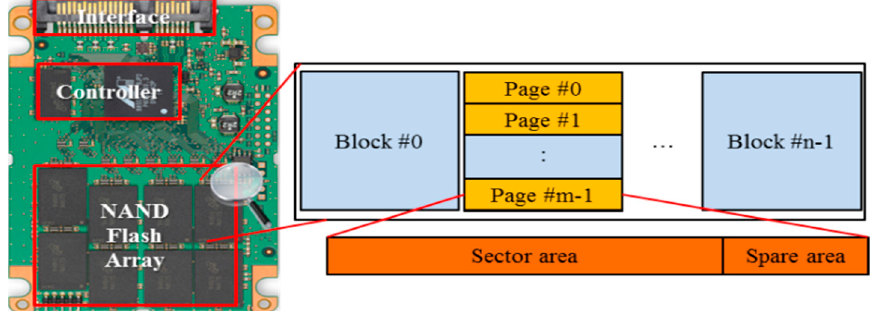
Figure 1. The architecture of the flash storage device.